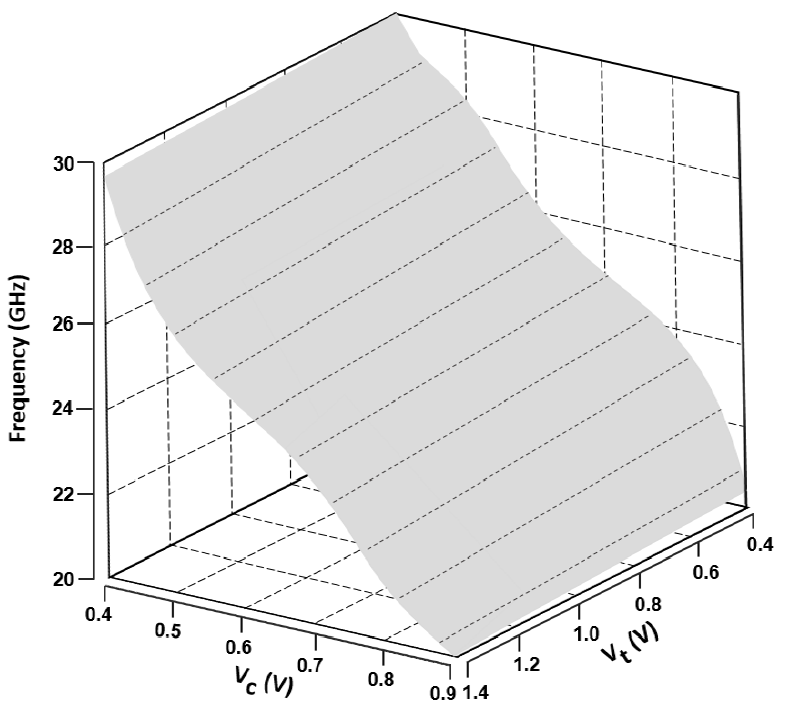
Figure 15. Graphical representation of the wide frequency tuning range of the VCO.